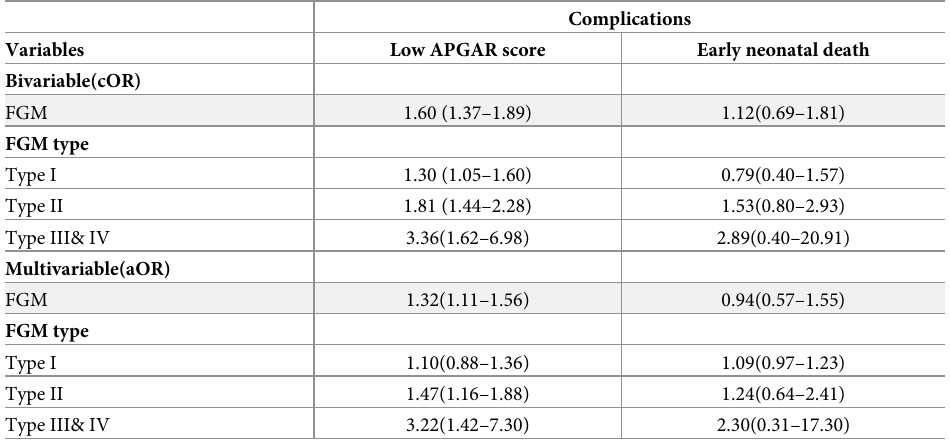
Table 4. Neonatal adverse outcomes associated with FGM (N =